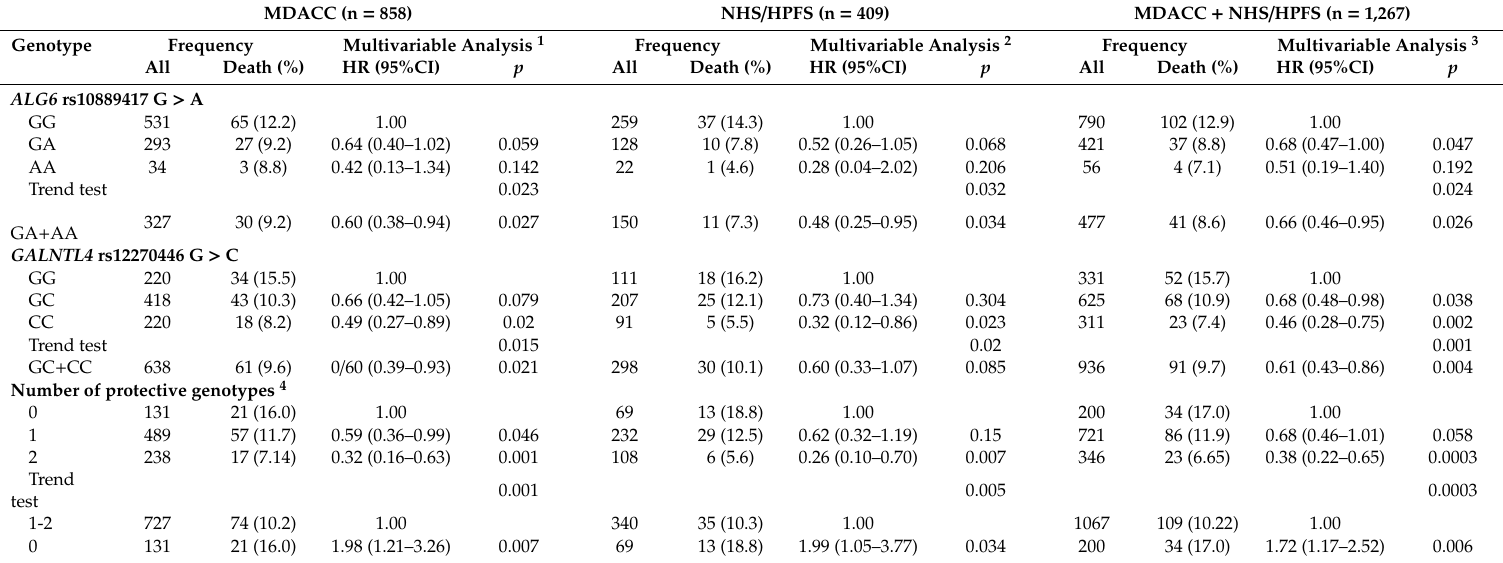
Table 3. Associations between two independent SNPs in the glycosylation-related genes and CMSS of patients in the MDACC dataset, the NHS / HPFS dataset, and the MDACC and NHS / HPFS combined dataset. MDACC (n = 858) MDACC + NHS / HPFS (n = 1,267) Genotype Frequency Multivariable Analysis 1 Frequency Multivariable Analysis 2 Frequency Multivariable Analysis 3